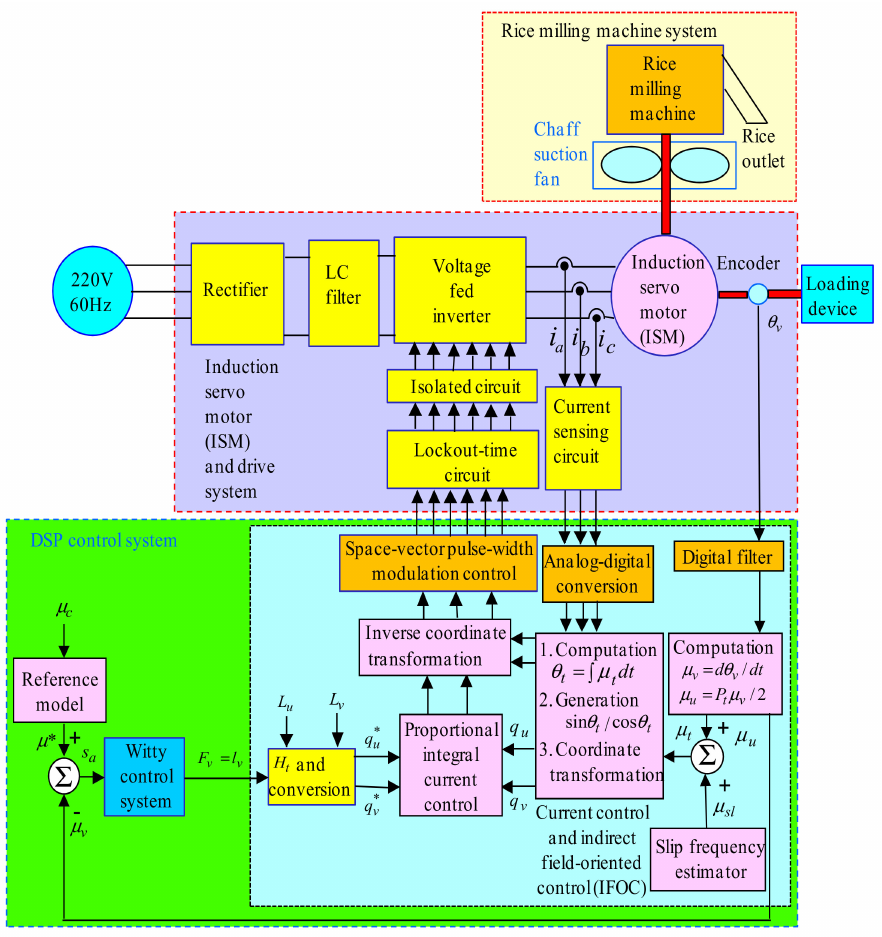
Figure 1. Arrangement of the induction servo motor (ISM) driving the rice milling machine